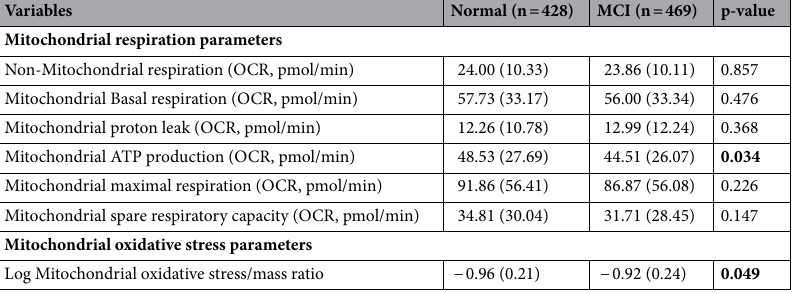
Table 2. Comparison of mitochondrial respiration parameters and mitochondrial oxidative stress parameters between normal and MCI participants. Data are presented as mean (standard deviation) and are compared between normal and MCI participants by Student’s t-test. Bold values represent a statistical significance. ATP adenosine triphosphate, OCR oxygen consumption rate.